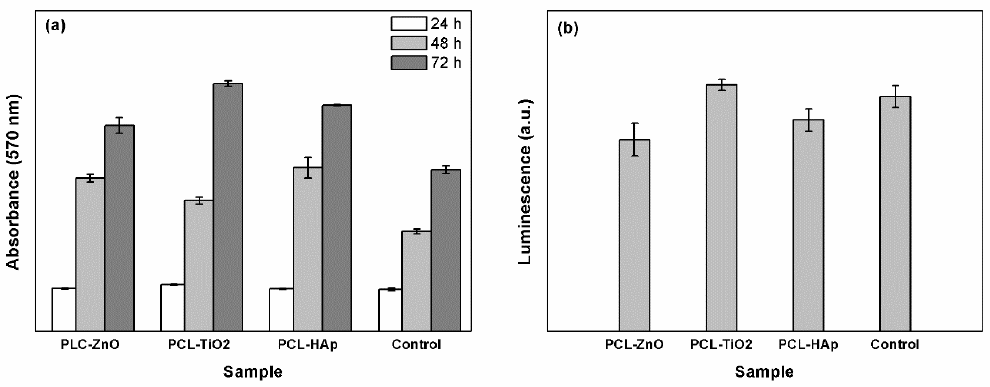
Figure 5. Biological evaluation of the composite scaffolds: ( a ) MTT assay, and ( b ) GSH assay.